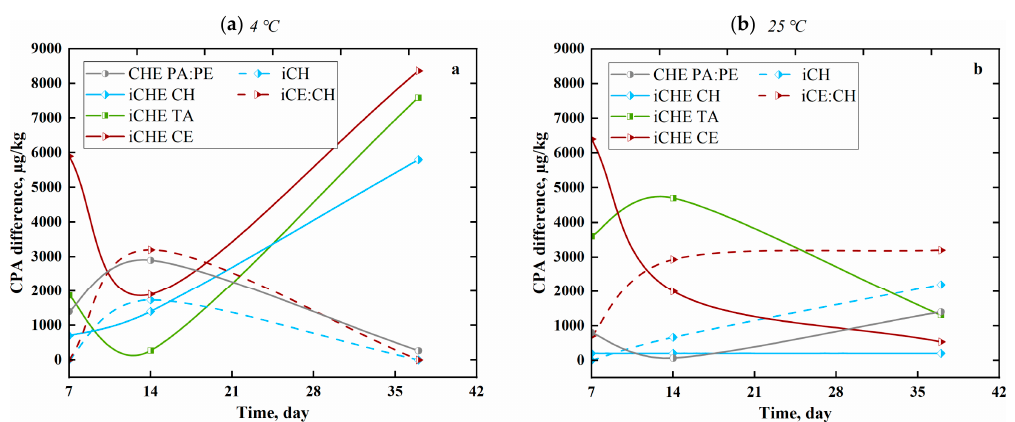
Figure 3. The effect of biopolymer films (CH, TA:CH, CE:CH) on cyclopiazonic acid (CPA) production in cheese (0.5 g), compared with mycotoxin accumulation in films (2 × 2 cm) at: ( a ) 4 °C and ( b ) 25 °C. Dashed lines represent packaging material results. Values are gained by subtraction of spiked non-inoculated sample mean from the spiked inoculated sample mean values, which are significantly different within rows ( p < 0.05; Table S2).